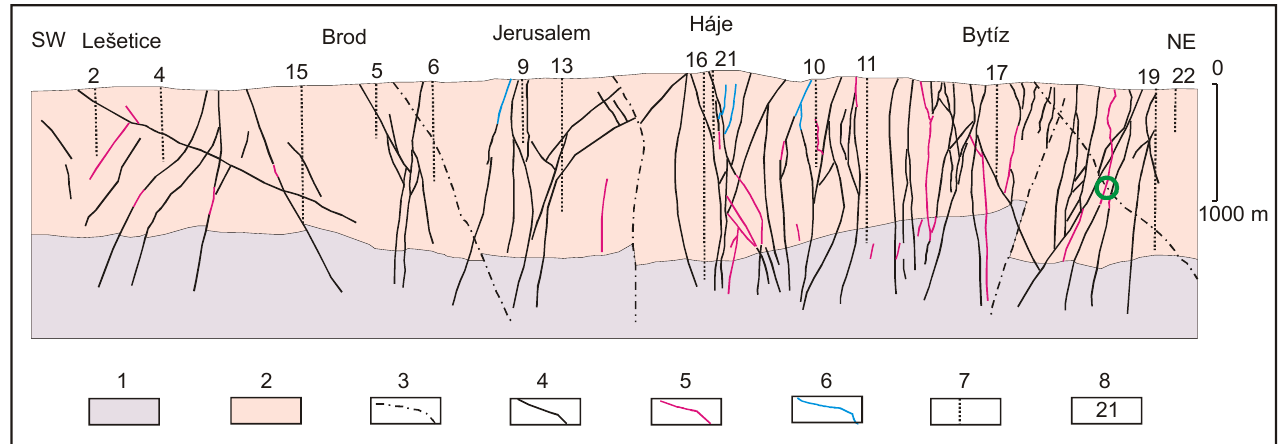
Figure 2. The SW–NE section of the P ř íbram uranium ore district (modified from Komínek [7]); localization of described ore stope is marked by green circle; 1—tuffs and tuffites of the Davle Group (Neoproterozoic); 2—claystones, siltstones, and sandstones of the Dob ř íš Group (Neoproterozoic); 3—faults; 4—hydrothermal veins with uranium mineralization; 5—hydrothermal veins with base- metal mineralization; 6—hydrothermal veins with monometallic Ag mineralization; 7—shafts; 8— shaft numbers.